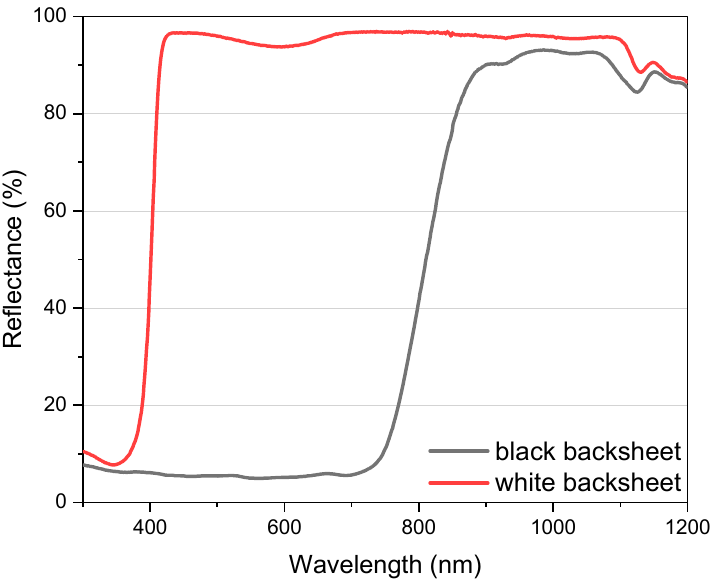
Figure 2. The reflectance of white and black backsheets in the vis–near-infrared (IR) range.